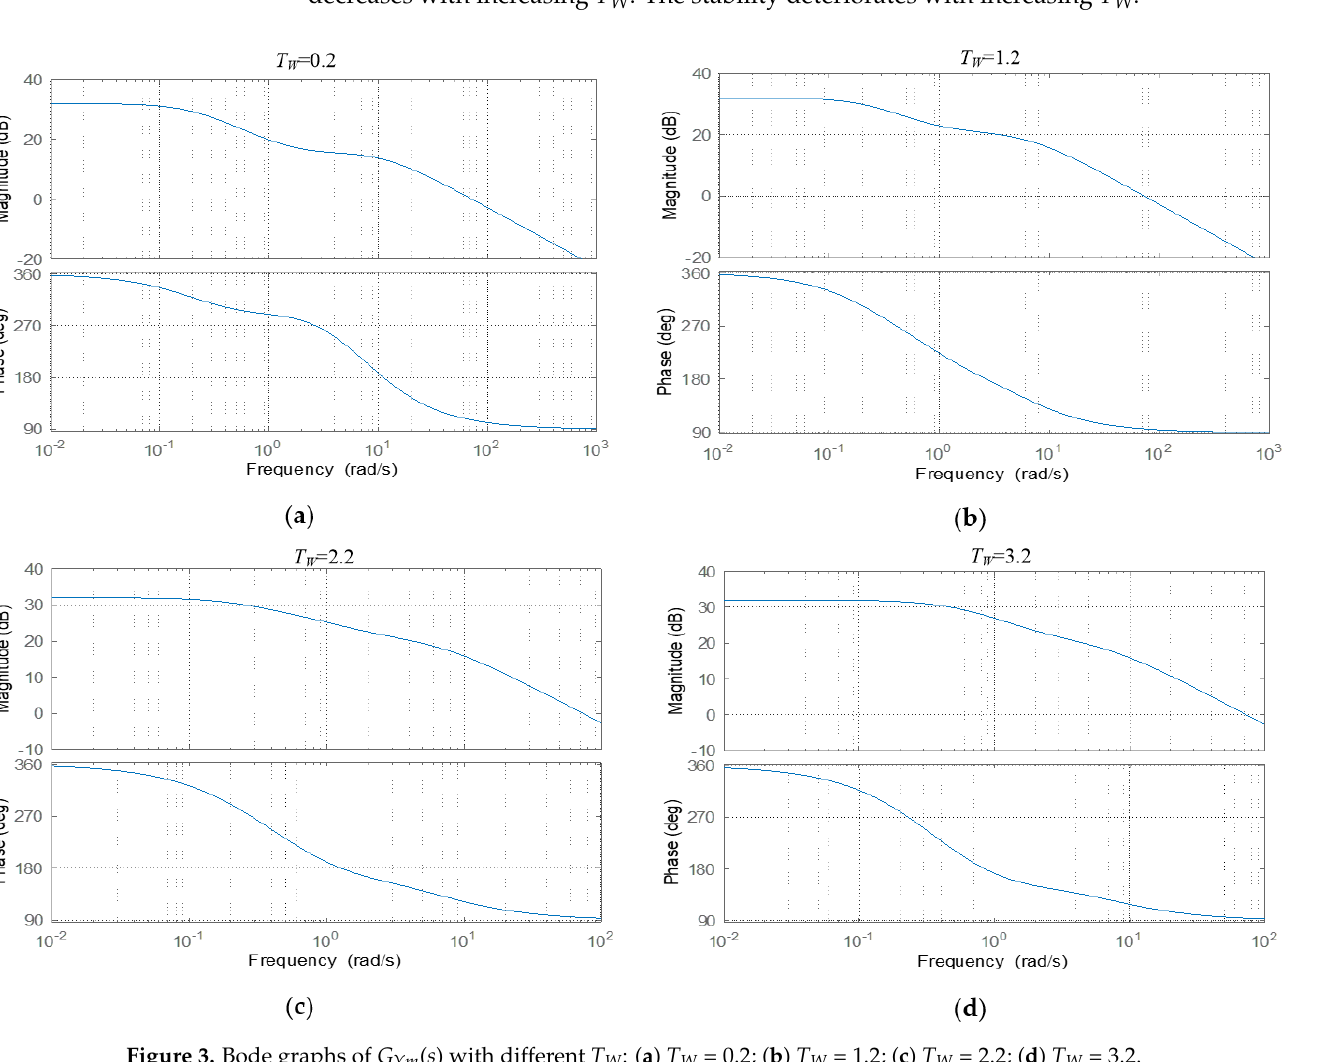
Figure 3. Bode graphs of G Ym ( s ) with different T W : ( a ) T W = 0.2; ( b ) T W = 1.2; ( c ) T W = 2.2; ( d ) T W = 3.2.